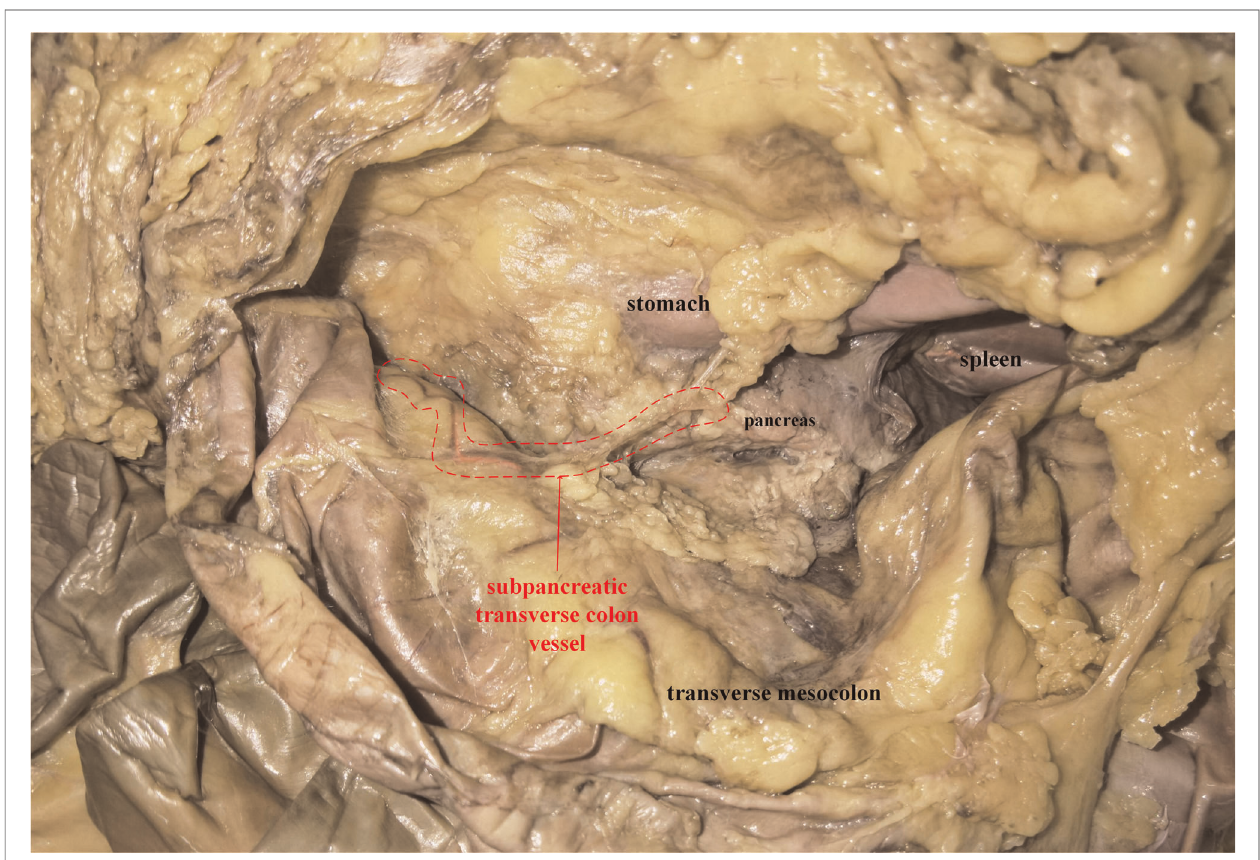
FIGURE 5 | A plane view of pancreas-transverse mesocolon in a cadaver: the subpancreatic transverse colon vessel was circled (red dotted line). And the vessel was conducted with angiography prior to dissection. The artery was pink, while the vein was